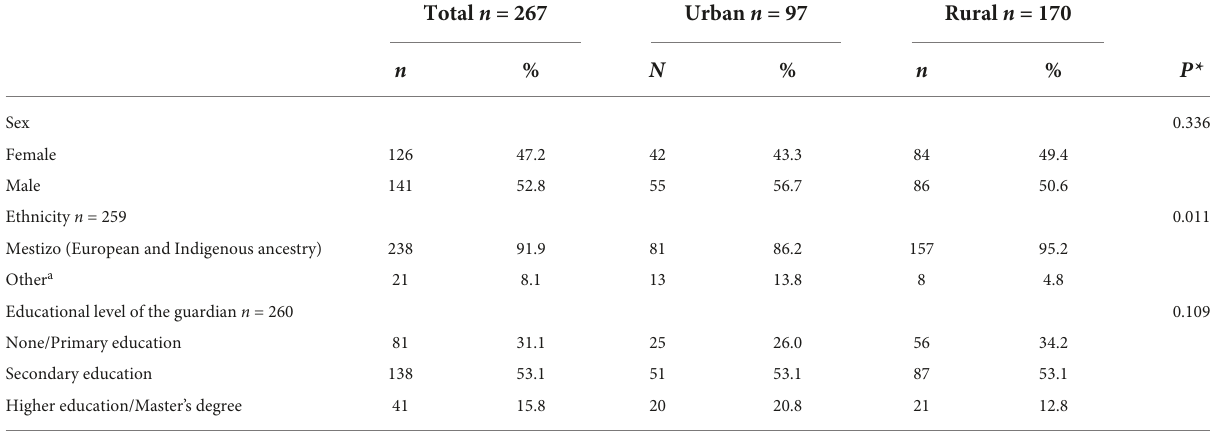
TABLE 1 Sociodemographic characteristics of the study